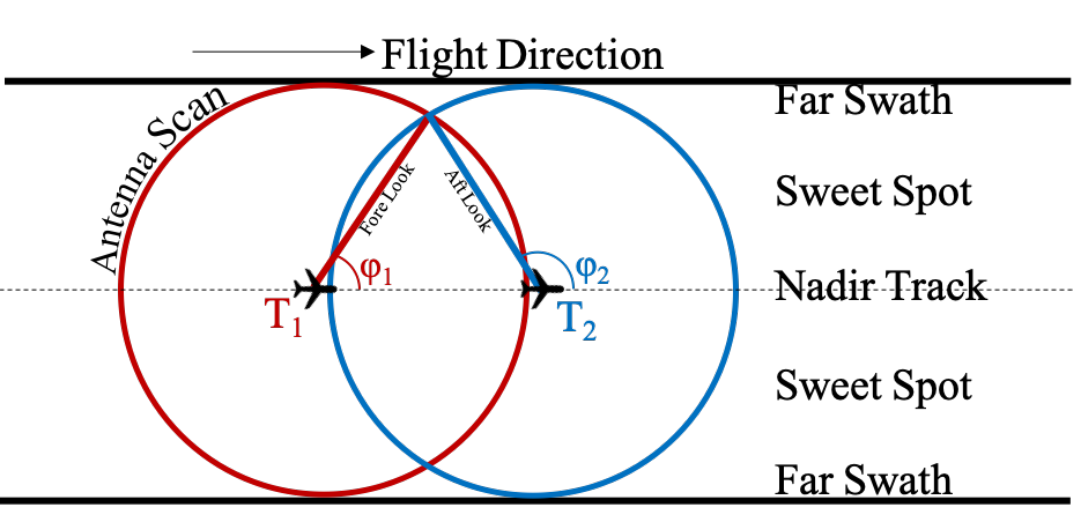
Figure 1. The scan geometry for Doppler scatterometry. As the airplane (or spacecraft) flies, every point on the ground is imaged looking forward at T 1 and again looking backward at T 2 . This builds up a wide swath and allows for vector current